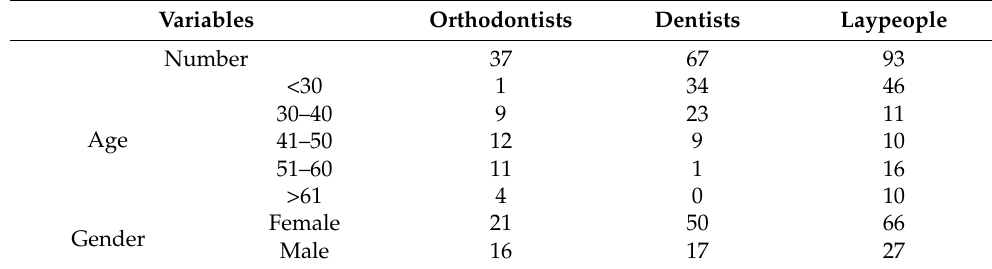
Table 2. Demographic distributions of the three groups of raters (orthodontists, dentists, laypeople). Variables Orthodontists Dentists Laypeople